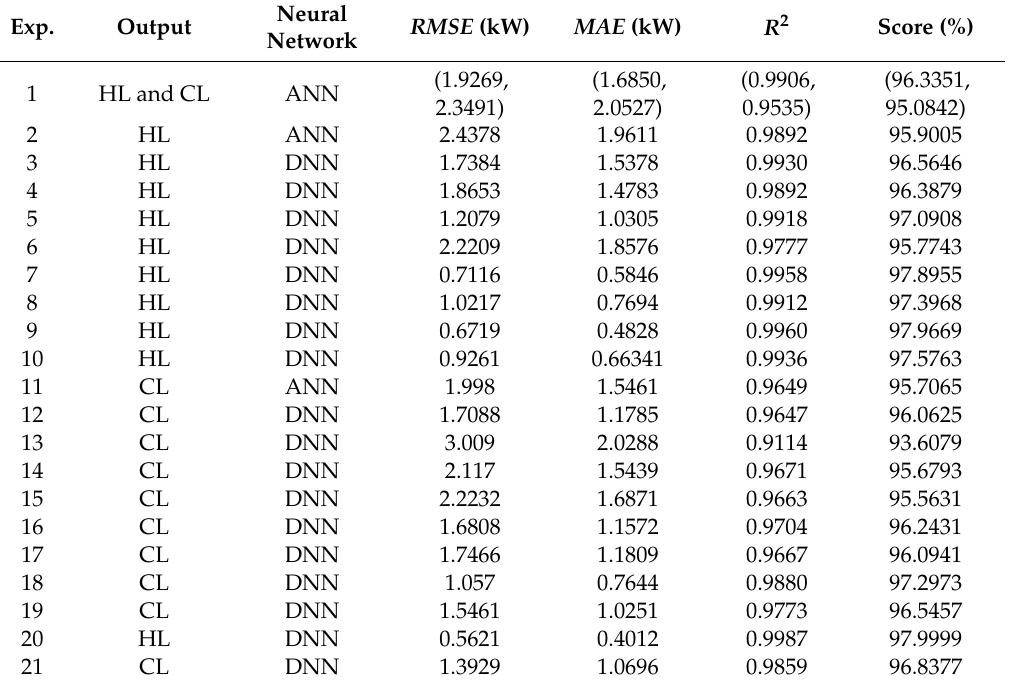
Table 4. Testing